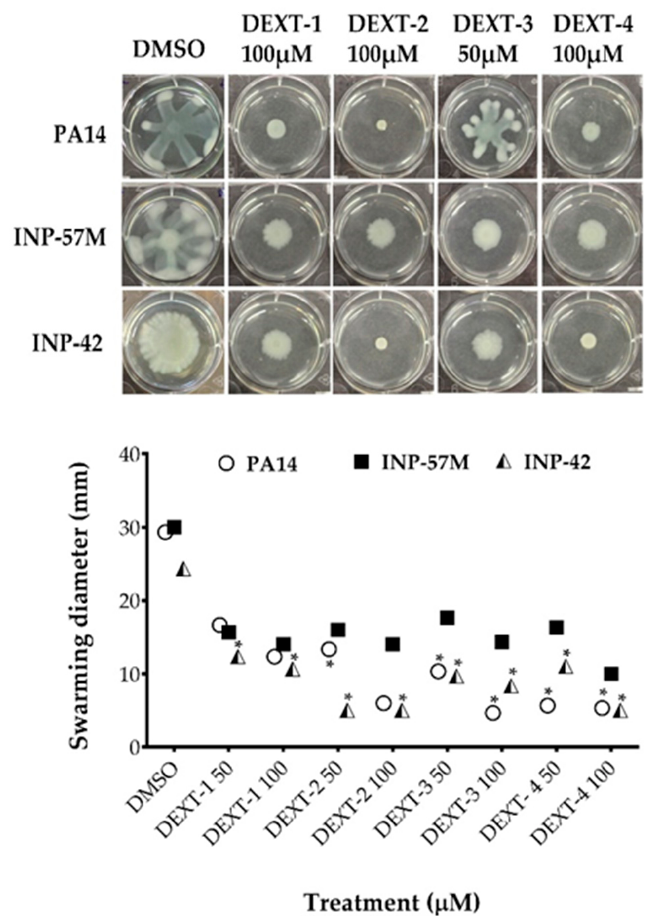
Figure 2. Effect of halogenated pyrrolidones on swarming motility of P. aeruginosa PA14 WT and clinical isolates (INP-57M and INP-42). Values are presented as means ± SD. The Student’s t -test was used to calculate the differences between two mean values (* p <